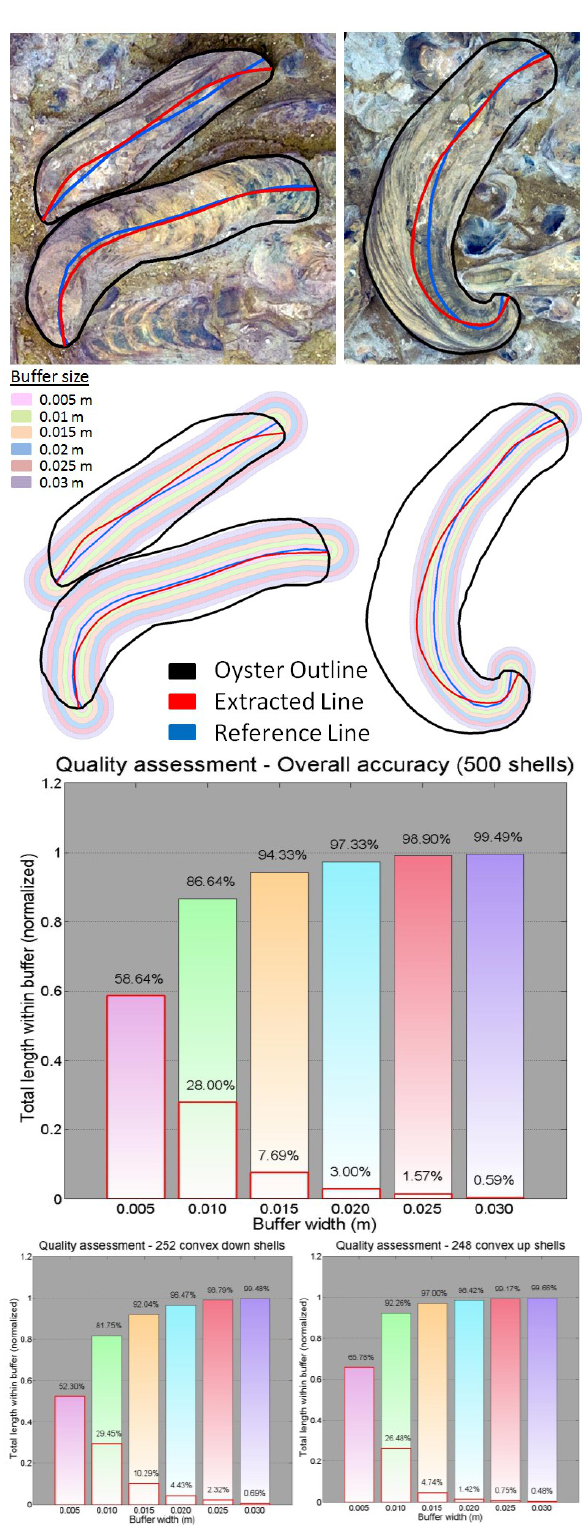
Figure 9: (Top two rows) Buffer zones growing around reference central line (blue) and visualized extracted line (red); (Bottom two rows) Quality assessment – overall, convex down, convex up accuracy of accumulative and buffer wise extracted line